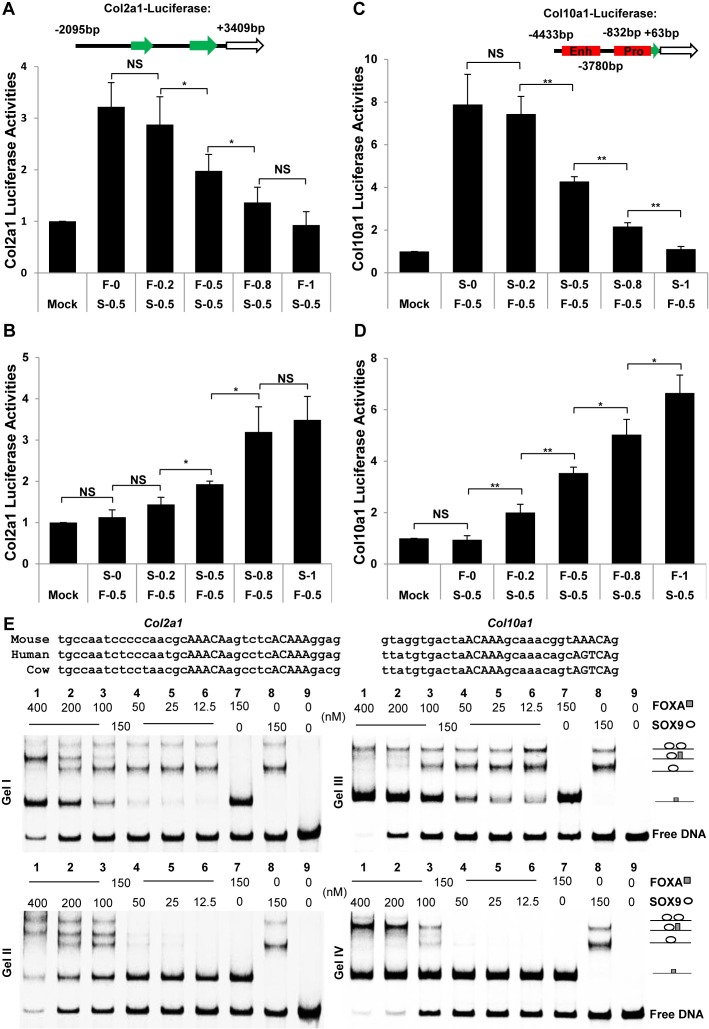
Competition between SOX9 and FOXA2 during chondrocyte differentiation.(A-D) Competition between SOX9 and FOXA2 on Col2a1 intron 1 and Col10a1 enhancer by luciferase assay in ATDC5. Enh: enhancer; Pro: promoter. The amount of SOX9 was kept constant and FOXA2 was increased and vice versa. (E) EMSA was performed using probes for the Col2a1 intron I (Gel I and II) and Col10a1 enhancer (Gel III and IV), and SOX9 and FOXA proteins at indicated concentrations. The sequences from Col2a1 intron I and Col10a1 enhancer used in the EMSAs are shown in the upper panel, and the SOX9/FOXA binding motifs are indicated by capital letters. **: p-value < 0.01; *: p-value < 0.05; NS: Non-significant.